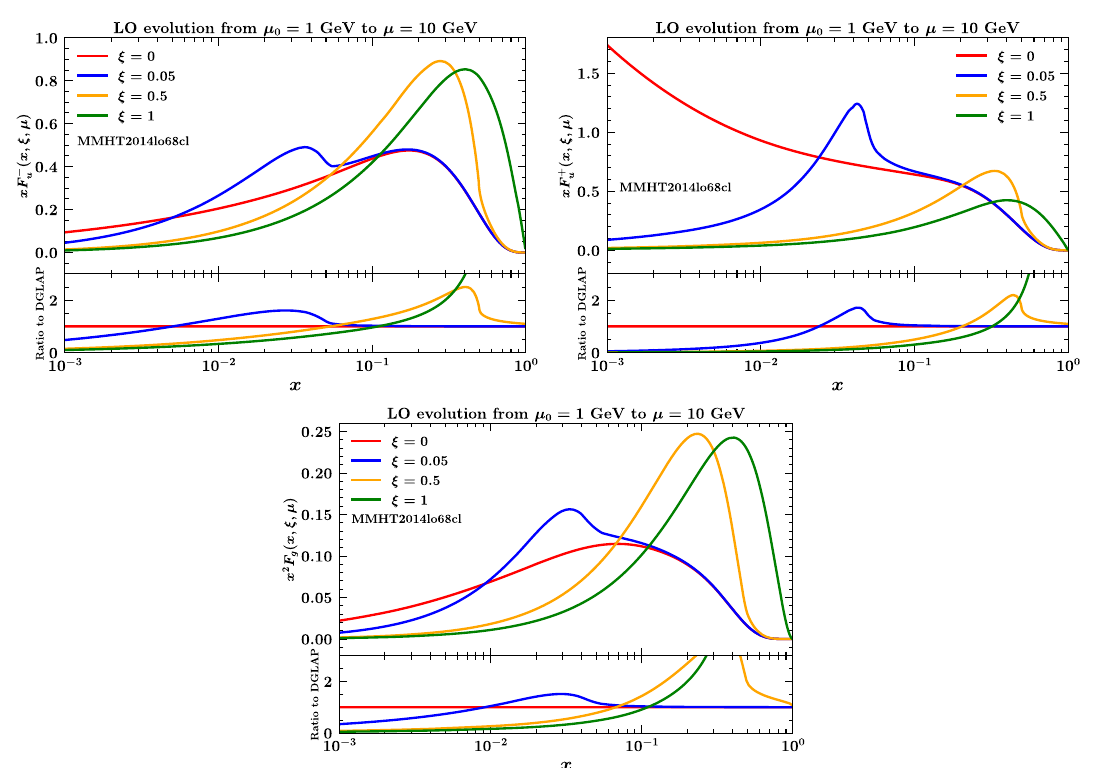
Fig. 3 Non-singlet up-quark (upper left) and singlet up-quark (upper right), and gluon (bottom) distributions evolved from μ 0 = 1 GeV to μ = 10 GeV using the GPD evolution equations in Eq. (28) with differ- ent values of the skewness ξ . Initial-scale distributions are taken from